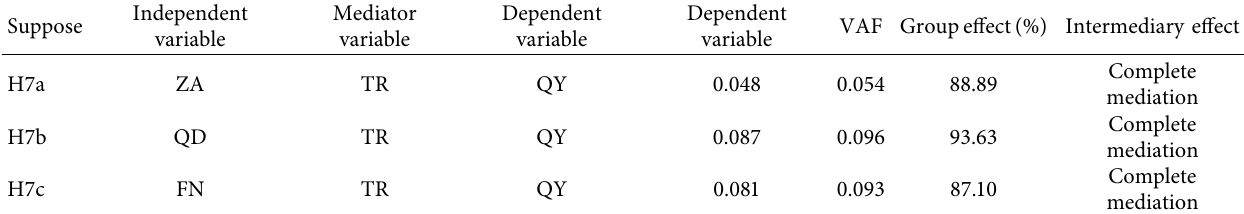
Table 6: Intermediary effect of innovation